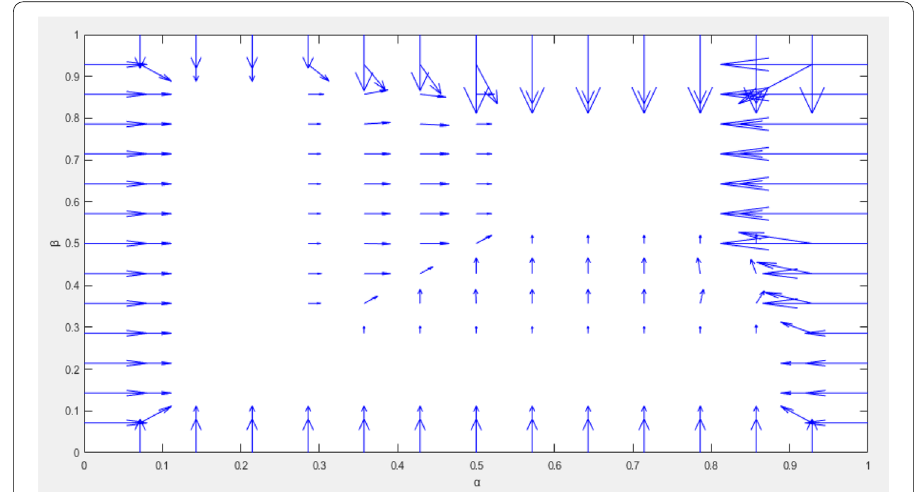
Fig. 6 Model dependency α and β on the security risk